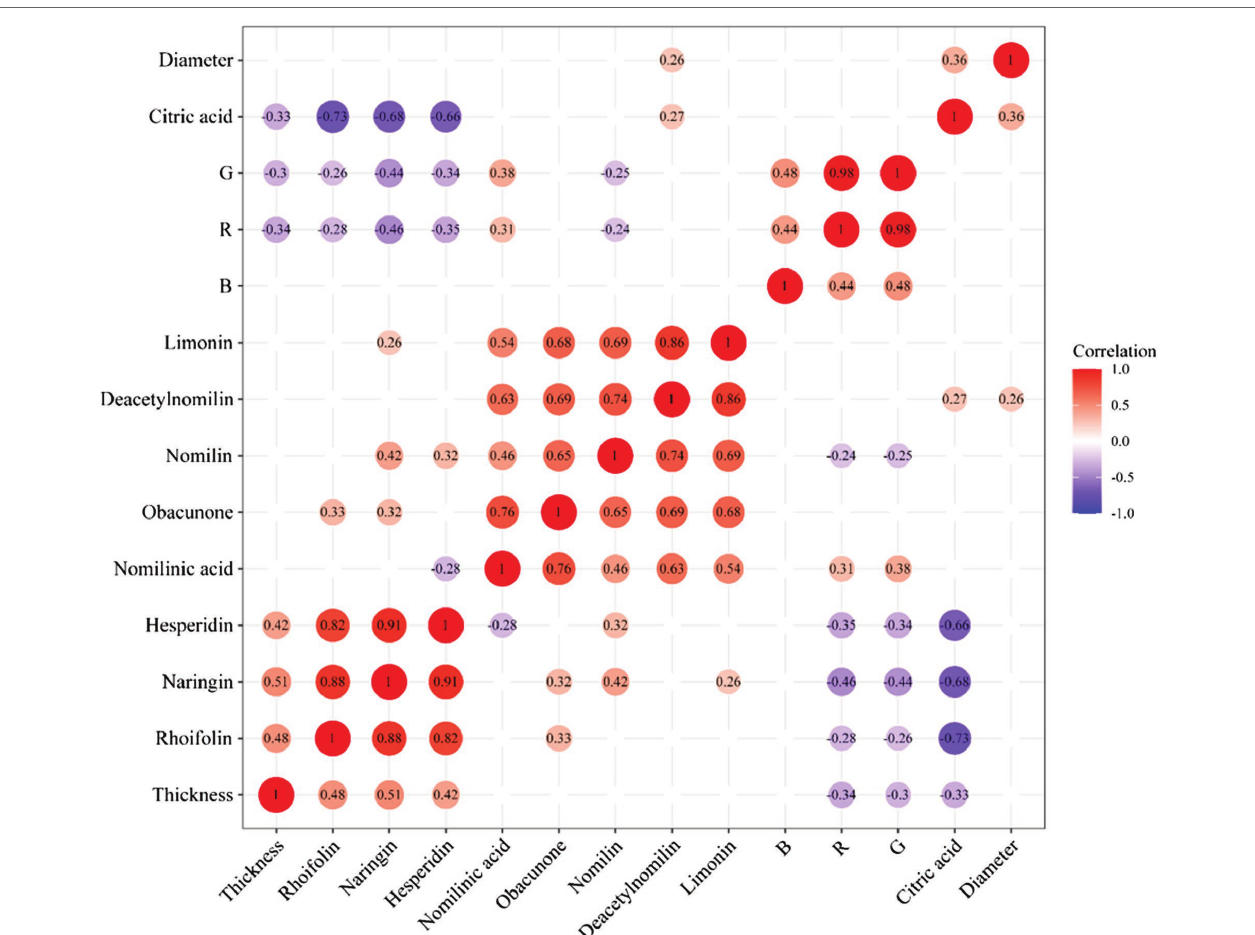
FIGURE 9 | Correlation analysis of differential metabolites and appearance index.